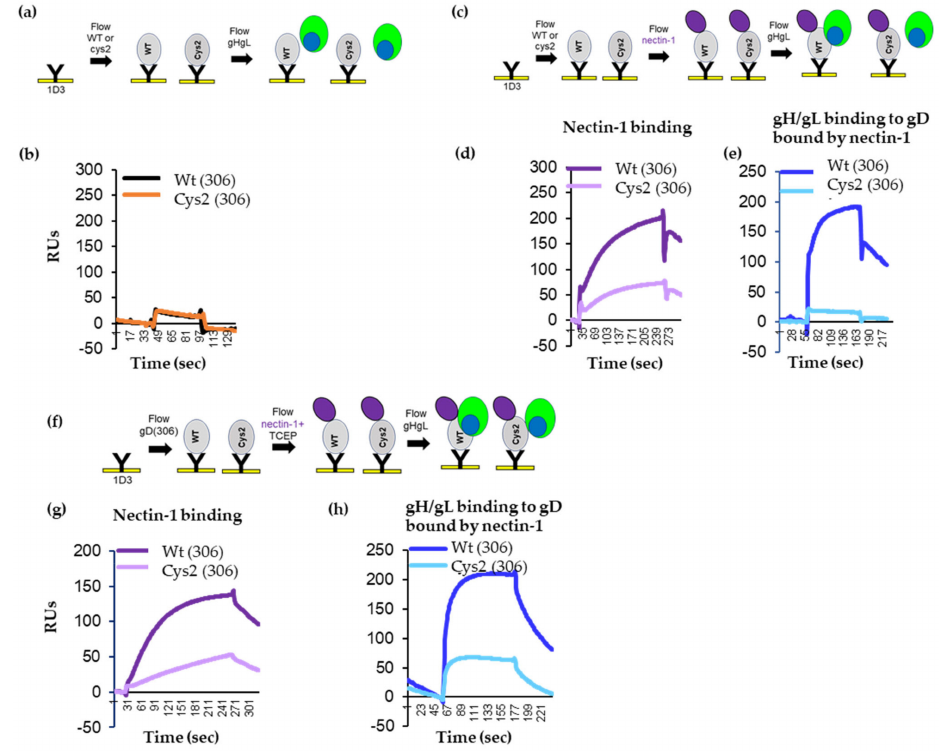
Figure 4. Characterization of wt and cys2 proteins. ( a ) Diagram of the Biacore 3000 protocol for analyzing gH/gL binding to gD, wt or cys2. ( b ) Soluble wt 306t and cys2 306t proteins were attached to the biosensor chip via 1D3 Mab. Soluble gH/gL was injected across the chip surface. Only the gH/gL binding curves are shown. Black curve, binding of gH/gL to wt gD; brown curve, binding of gH/gL to cys2. ( c ) Diagram of the Biacore 3000 protocol for analyzing the binding of gH/gL to a gD-nectin-1 receptor complex. gD molecules were attached to the biosensor chip via 1D3 Mab. Sequential injection of nectin-1 followed by injection of soluble gH/gL. ( d ) Nectin-1 binds to both wt (dark purple) and cys2 (light purple) gD proteins. ( e ) gH/gL bound to wt gD (blue) but not to cys2 mutant gD (cyan). ( f ) Diagram of the Biacore 3000 protocol for analyzing gD–gH/gL binding in the presence of TCEP. gD molecules were attached to the biosensor chip via 1D3 Mab. Nectin-1 was pre-mixed with 1 mM TCEP and flowed over the captured gD molecules, followed by the injection of soluble gH/gL. ( g ) Nectin-1 binds to both wt (purple) and cys2 (light purple) gD proteins. ( h ) As expected, gH/gL bound to wt gD (blue). Due to the reduction of the disulfide bond, gH/gL is now able to bind cys2 mutant gD as well